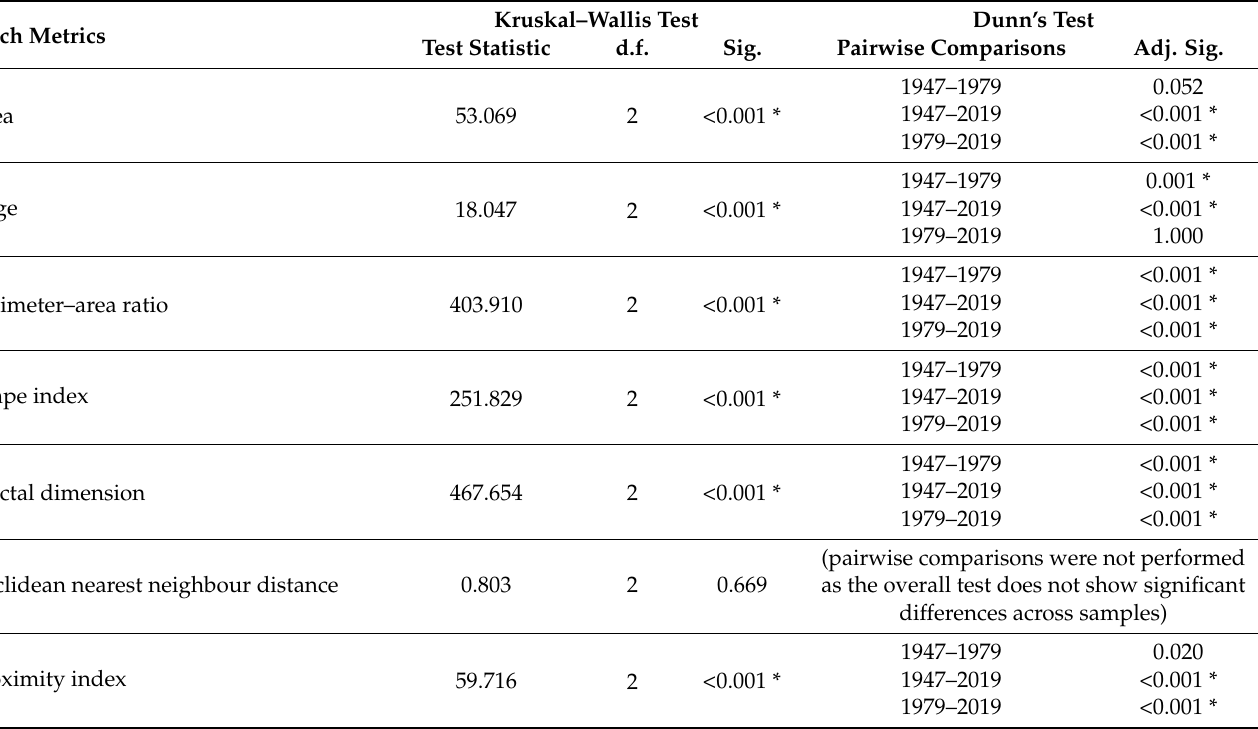
Table 3. Outputs of the Kruskal–Wallis test (and post hoc pairwise comparisons) on patch metrics, considering the analysis at the landscape level (N = 4411; significance values for Dunn’s test were adjusted by the Bonferroni correction for multiple